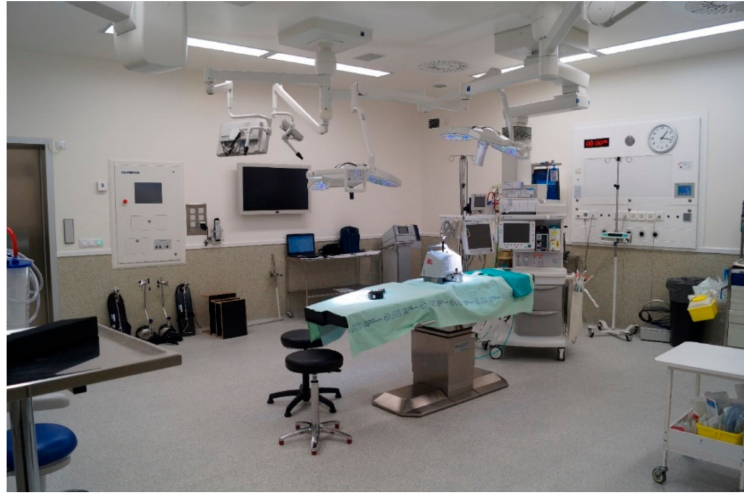
Figure 1. General view of operating room number 2.